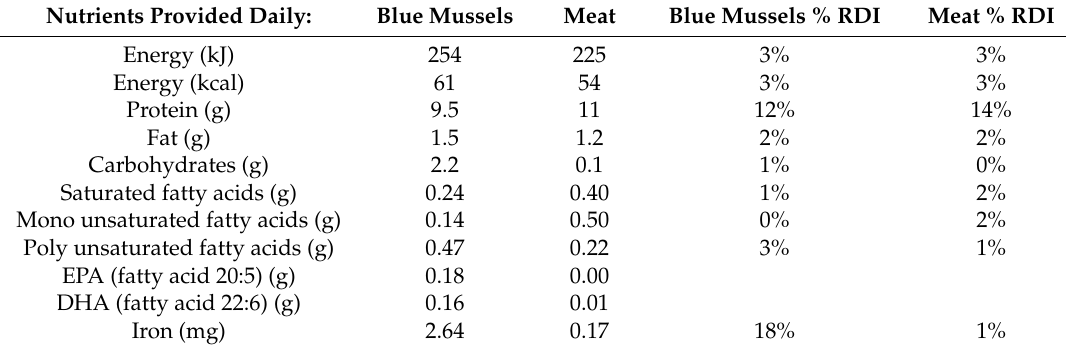
Table 3. Calculated daily nutrient intake and percentage of recommended daily intake (RDI) from blue mussels or